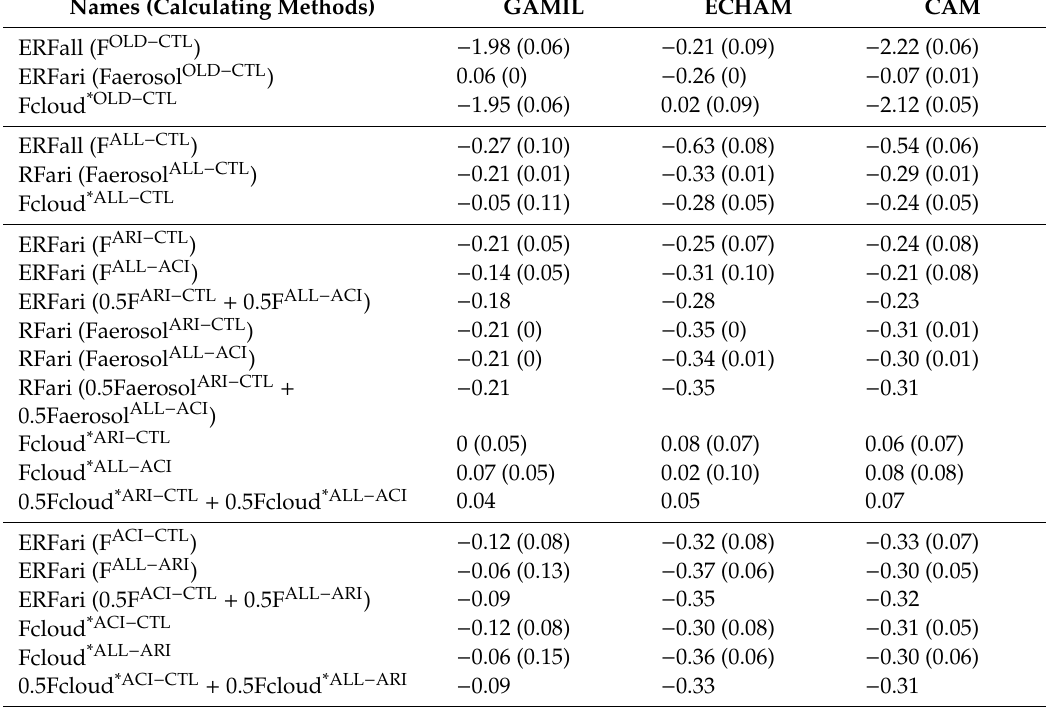
Table 6. Ensemble averages of e ff ective radiative forcing (ERF) and its two basic components, i.e., the instantaneous radiative forcing from aerosol–radiation interactions (RFari) and the aerosol-induced changes in cloud forcing. Standard deviations (in brackets) are calculated from the di ff erent ensemble